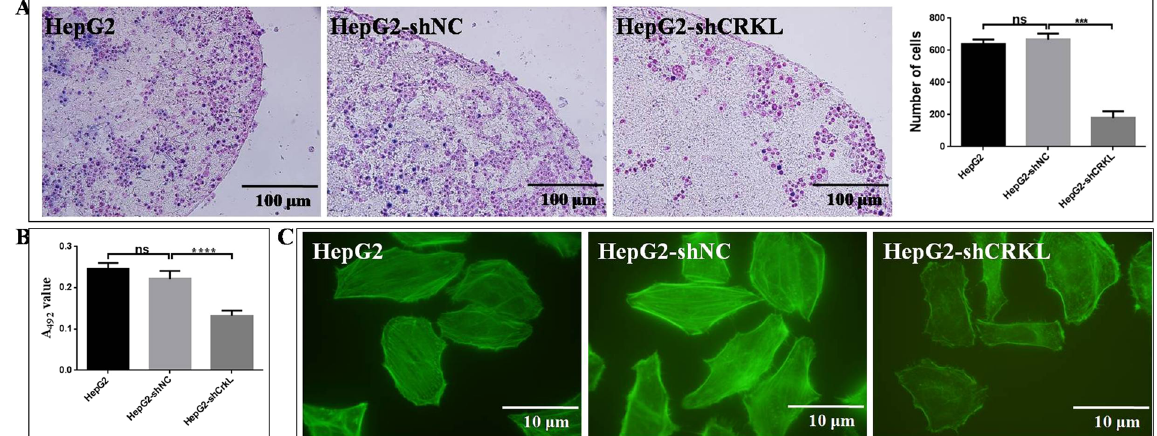
Figure 6. The effect of CRKL knockdown on cell adhesion ability and cytoskeleton F-actin in HepG2. ( A ) CRKL knockdown inhibited the in situ LN adhesion capacity of HepG2 cells ( **** refers to P < 0.0001). ( B ) CRKL knockdown inhibited the extracellular matrix adhesion ability of HepG2 cells to FN by MTT assay ( **** P < 0.0001). ( C ) CRKL knockdown decreased cytoskeleton F-actin protein expression and filament arrangement of HepG2 cells by FITC-phalloidin assay.